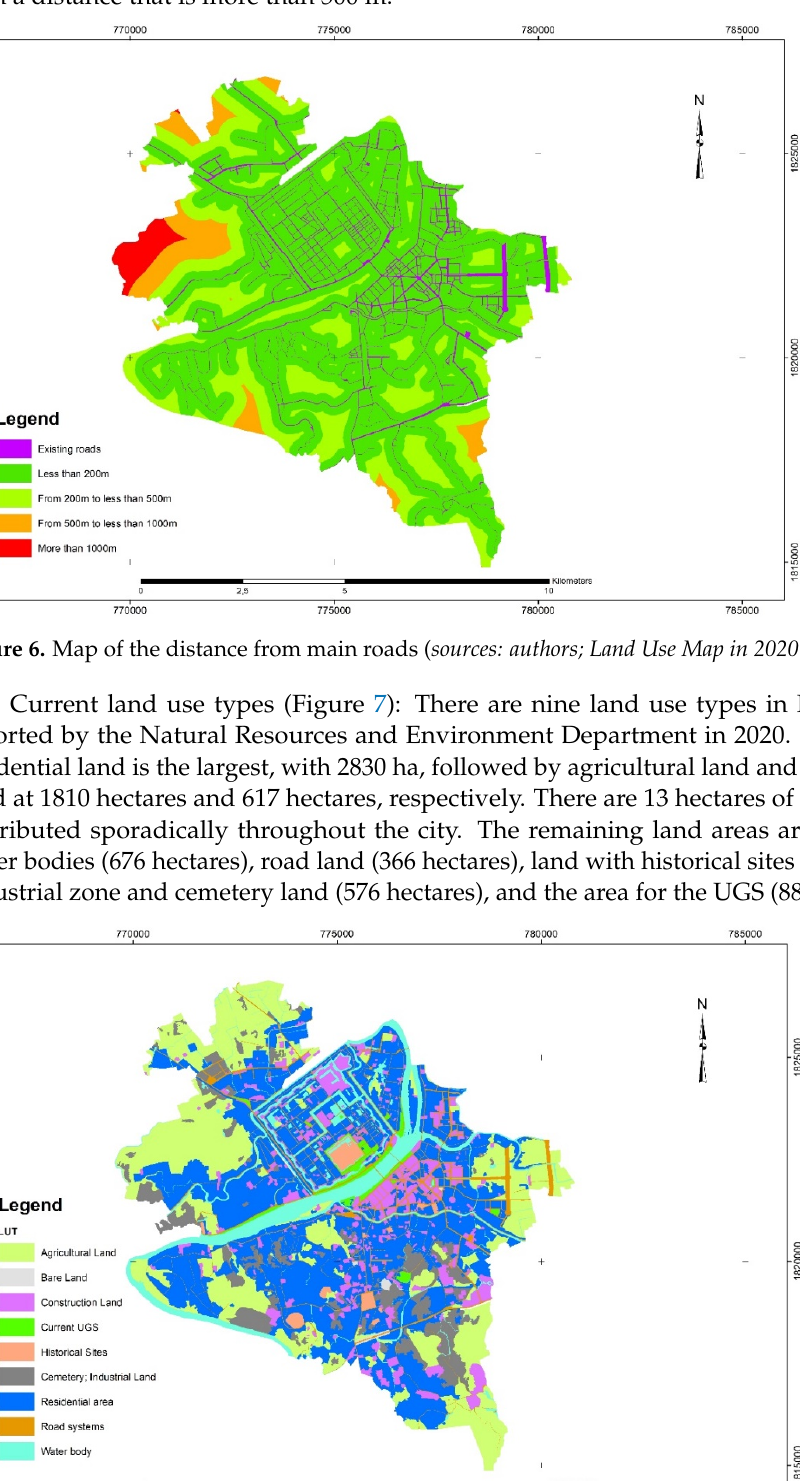
Figure 5. Map of the distance from existing residential areas ( sources: authors; Land Use Map in 2020 of Hue City ).